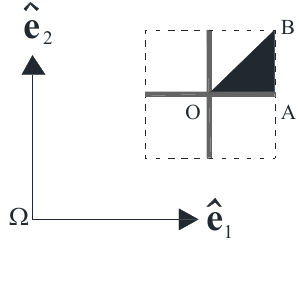
Figure 4. Irreducible part of the first Brillouin zone.